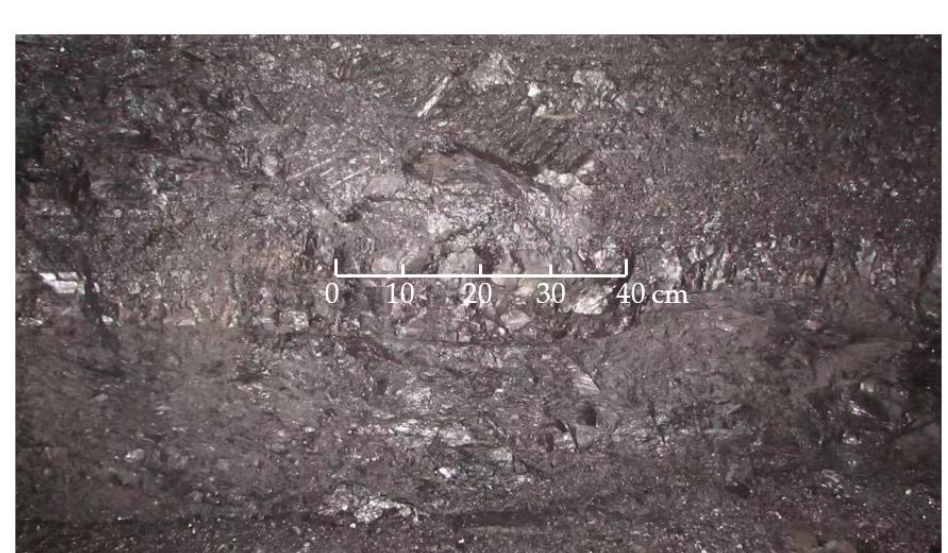
Figure 2. No. 8 coal concentrate of Wangping Ore Carbon Series.